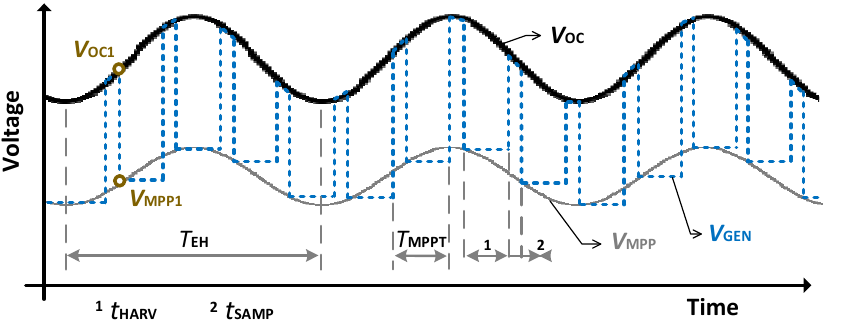
Figure 3. Sinusoidal V OC waveform with positive offset for a harvester (black line), the corresponding ideal V MPP (½ V OC: gray line) and the EH output ( V GEN : blue line) for a T MPPT sampling period using the FOCV-MPPT method.